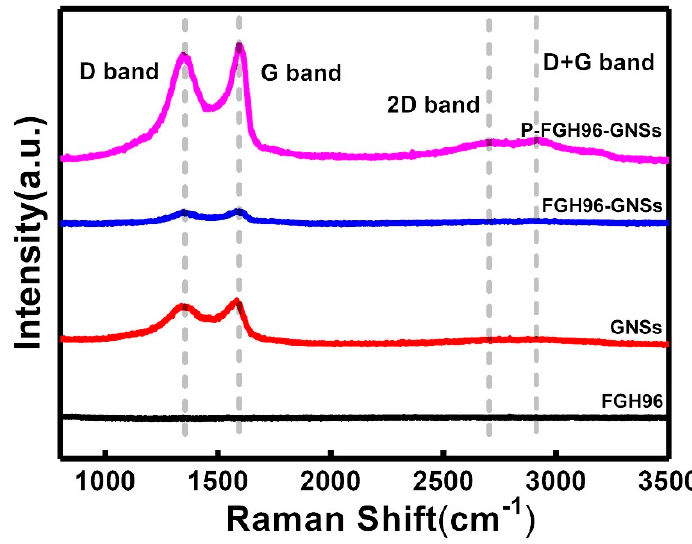
Figure 5. Raman spectra of the FGH96 powder, pristine GNSs, FGH96-GNSs powder, and P-FGH96- GNSs